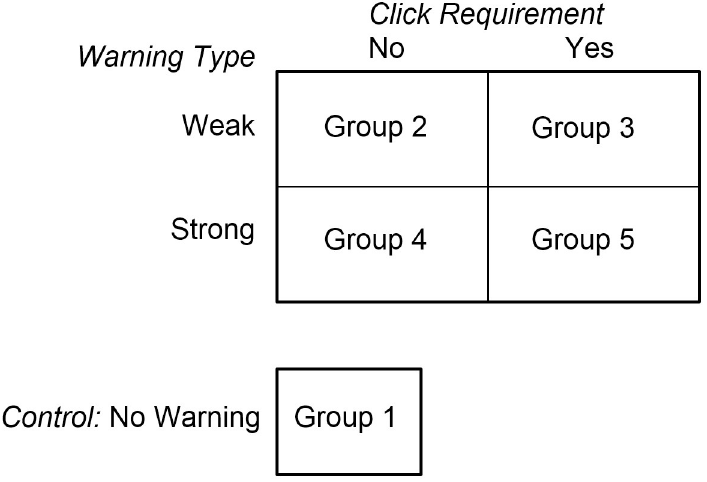
Fig 1. Experimental design. Participants in the control group (Group 1) were not shown a warning above the questionnaire. Participants in the other four groups were presented two levels of warning and two click conditions (click or no click required) in a 2 × 2 factorial design as shown in the